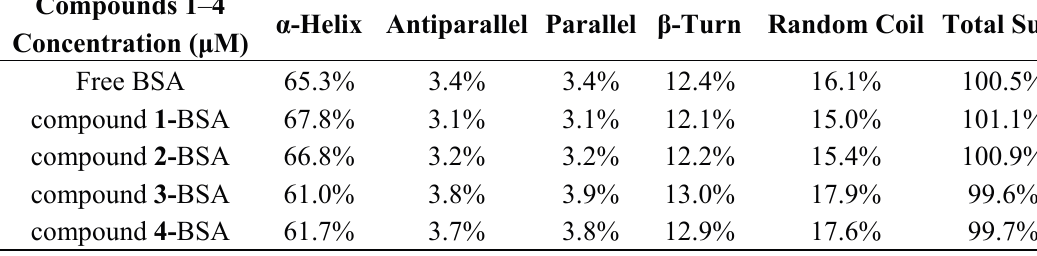
Table 3. Secondary structure of compounds 1 – 4- BSA complex (CD Spectra) at pH 7.4 as calculated by CCDN